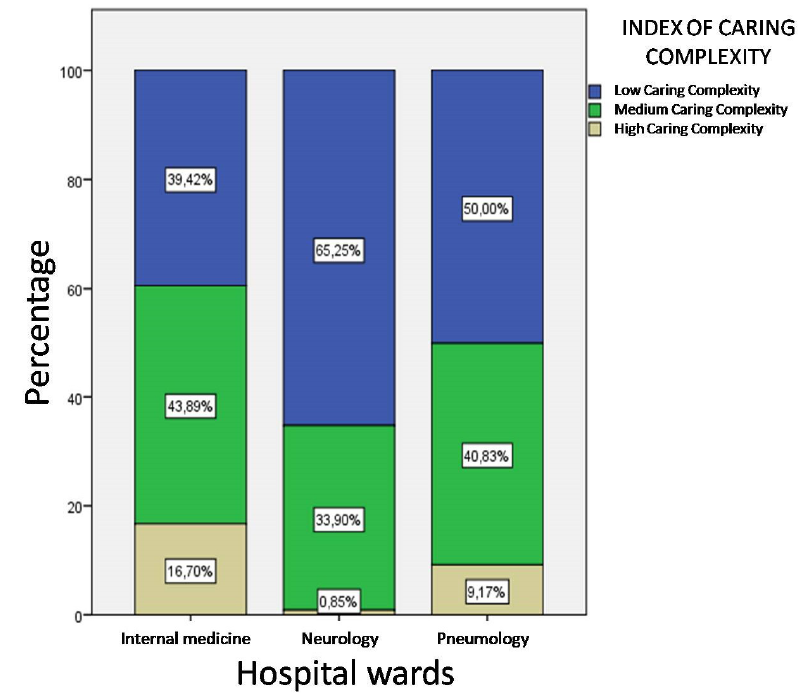
Figure 6. Distribution of care complexity levels by hospital wards.